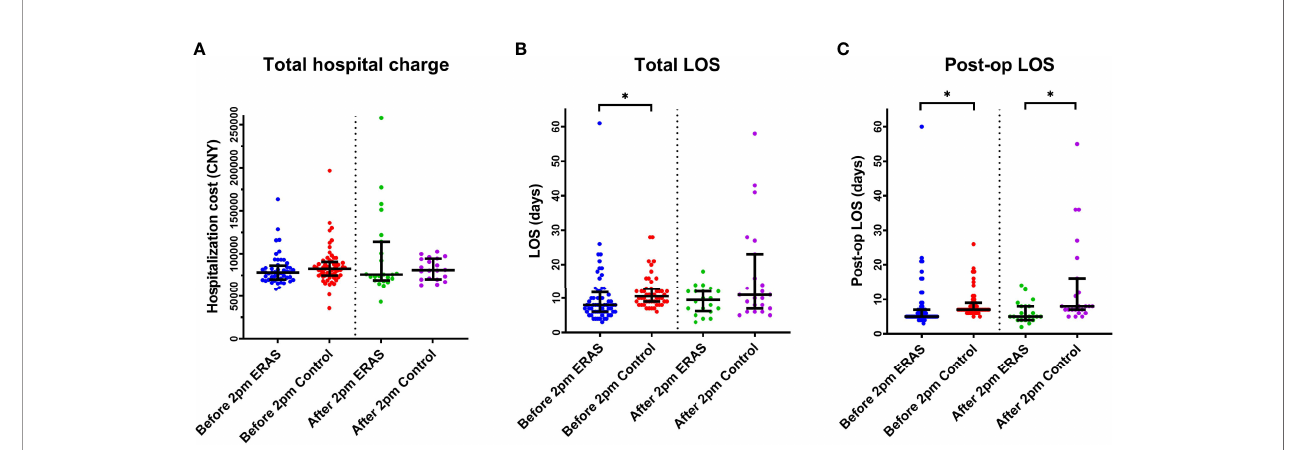
FIGURE 5 | The effect of surgical start time (before or after 2 PM) on both groups on Total Hospital charge (A) , Total LOS (B) and Post-op LOS (C) . *p < 0.05. LOS, Length of